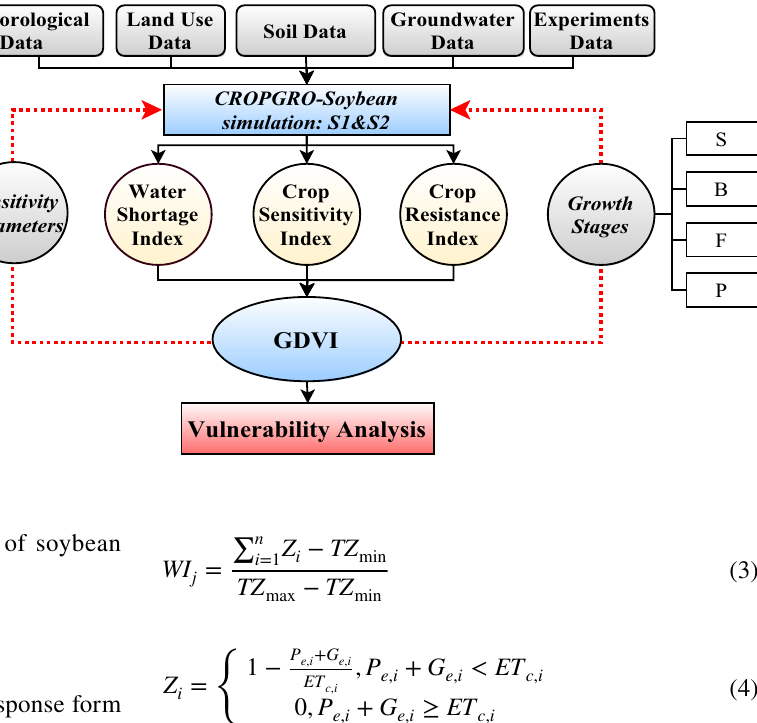
Fig. 2 Flowchart of the development of the soybean growth-stage-based drought loss vulnerability index (GDVI) in the Huaibei Plain study area in Anhui Province, China. Note: SLA = Specific leaf area; LAI = Leaf area index; TW = Tops weight; GW = Grain weight. S = Seedling stage; B = Branching stage; F = Flowering & pod-setting stage; P = Pod- filling stage